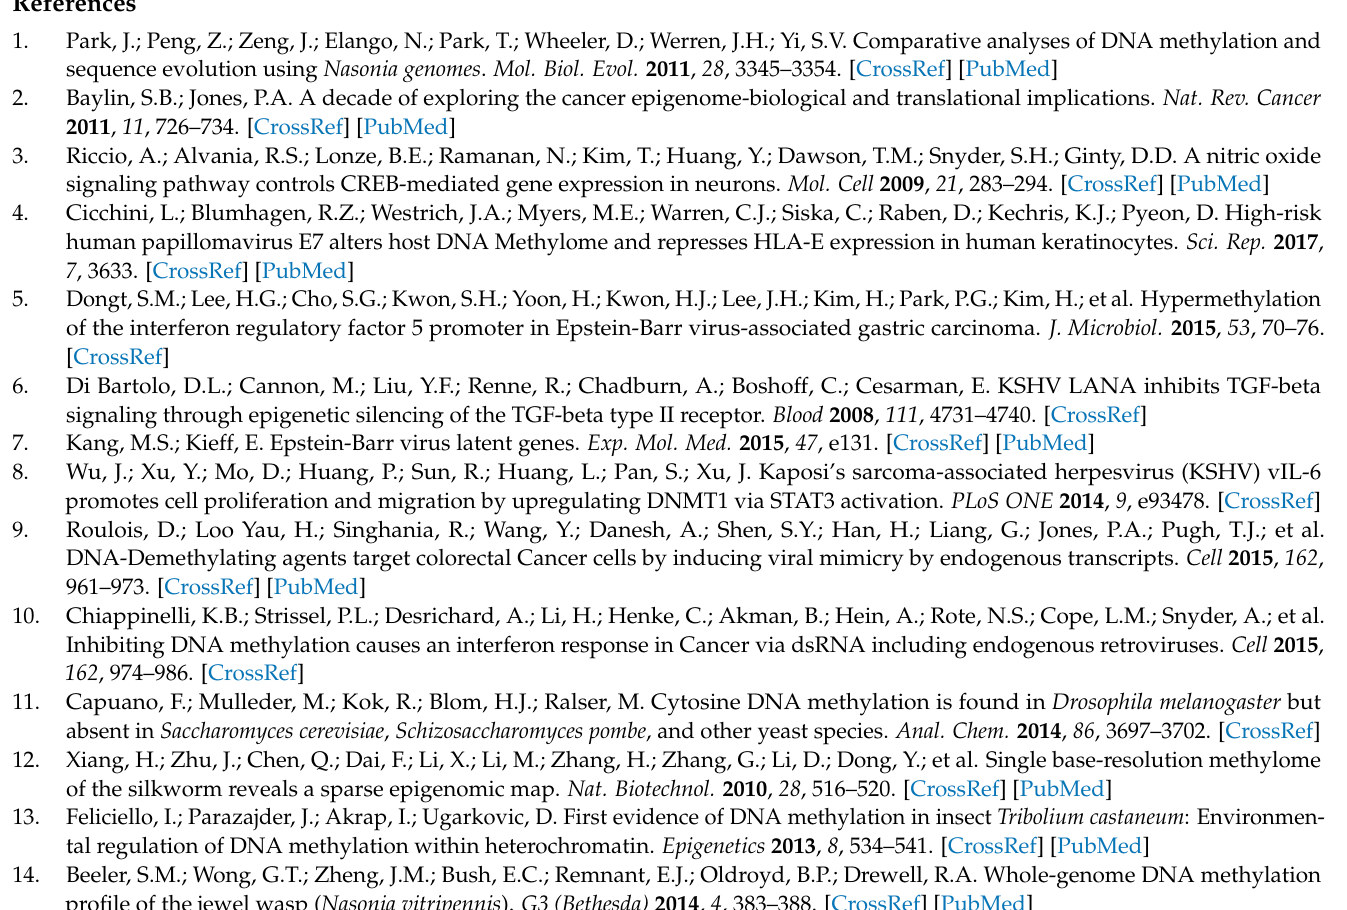
Table of GO Enrichment of All Genes and DEGs.; Table S4: Classification of the Unigenes Annotated in